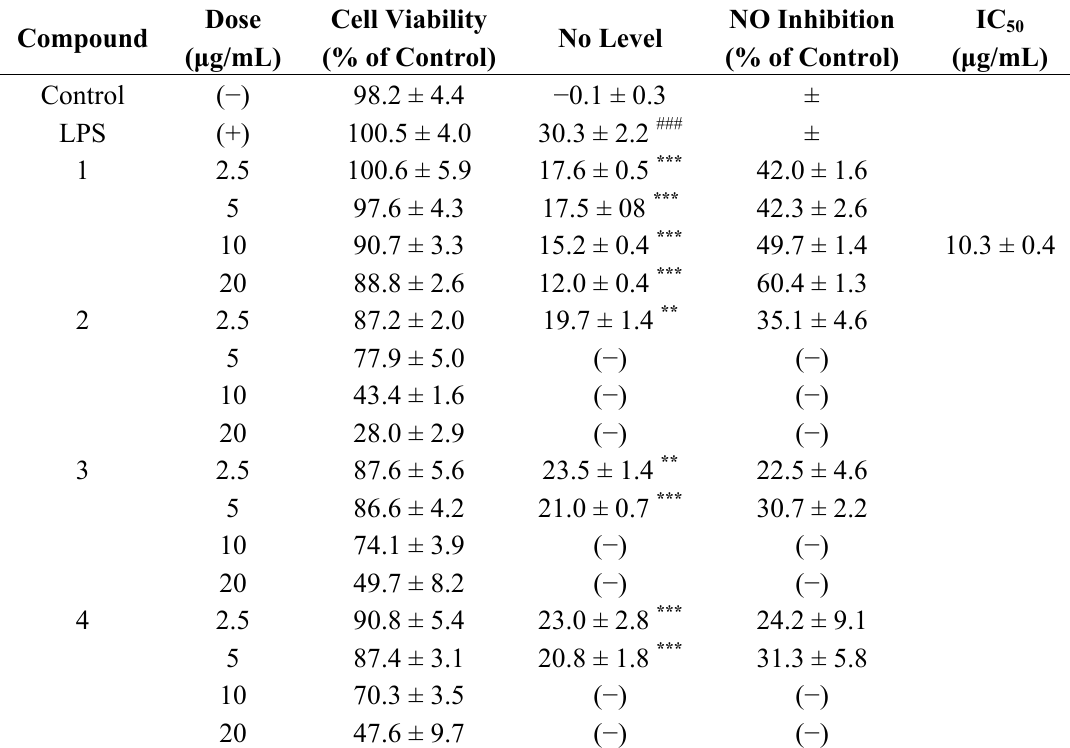
Table 2. Cell viability and effect of compounds 1 – 5 on LPS-induced NO production in macrophages a